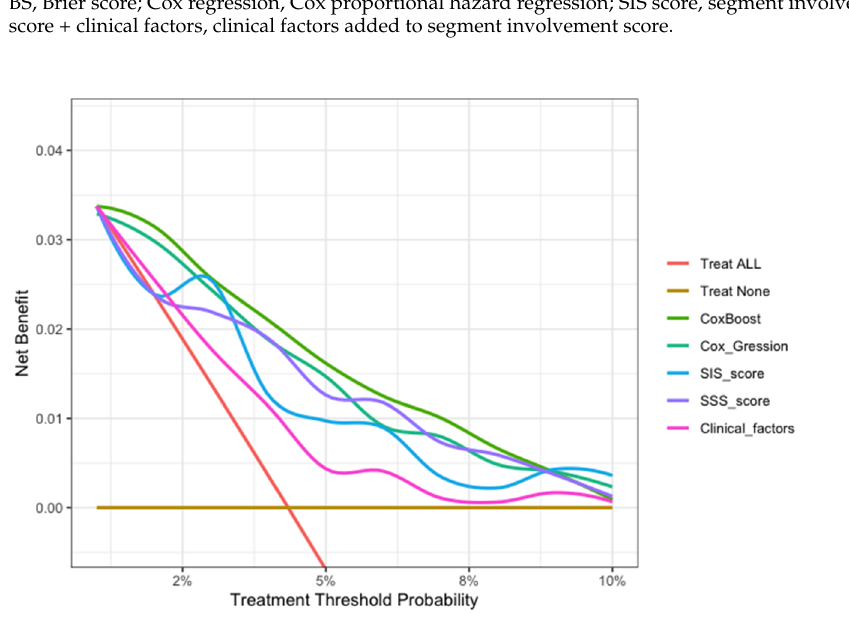
Figure 6. The decision curve analysis of all models for patients over 30 months. The brown transverse line = net benefit when all patients are considered as not having the outcome (MACEs); red oblique line = net benefit when all patients are considered as having the outcome (MACEs). The decision curve analysis of all models showed that the proportion of the benefit for the population each year was the highest when the risk assessment of the ML model was used for treatment, while the treatment threshold probability was between 1% and 9% over a period of approximately three